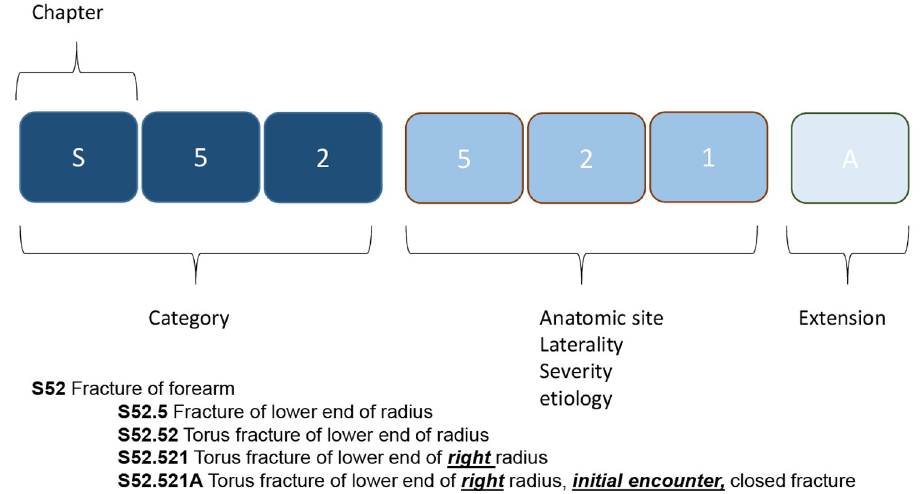
Fig 1. ICD-10-CM diagnosis code hierarchy and with example: S52, fracture of the forearm. The ICD-10-CM code consists of a chapter (S), category (S52) and full code (S52.521A).